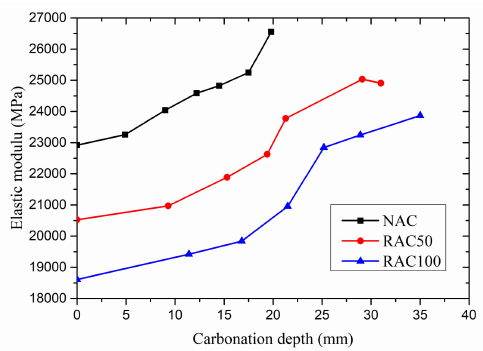
Figure 11. Elastic modulus versus carbonation